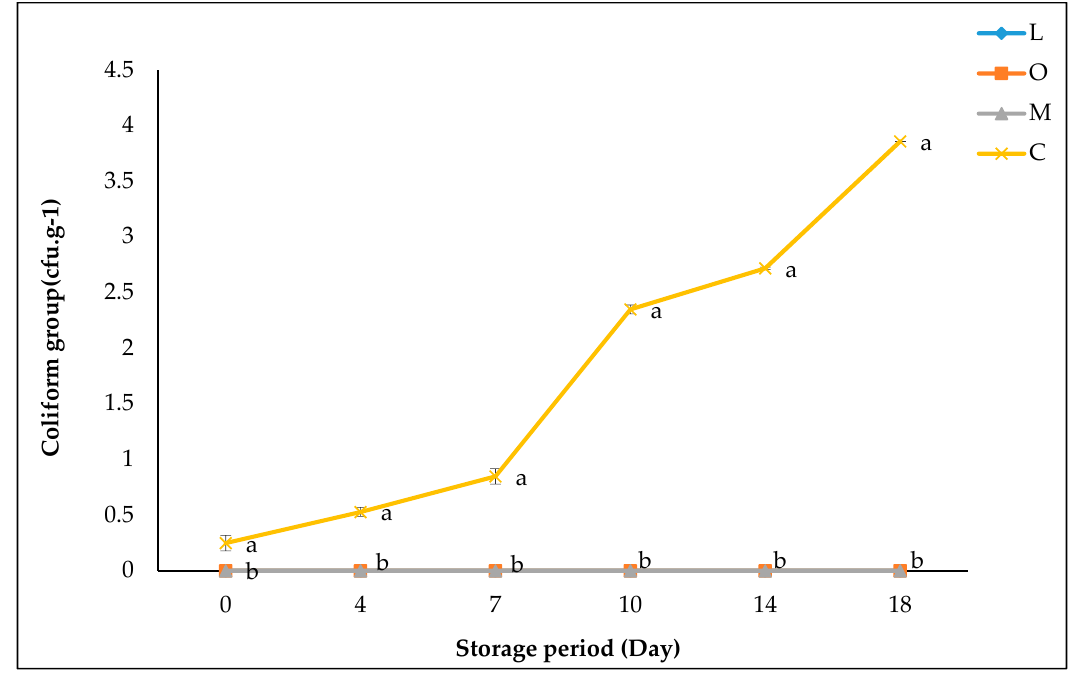
Figure 17. Effect of different essential oil emulsions (L = lemon, O = orange, and M = mandarin essential oil) on total coliform group of strawberry fruits stored at 2 °C for 18 days. Vertical bars indicate the standard deviation (n = 6). Means and different letters indicate significant difference between treated and control fruits at each storage period (Duncan’s of 95%).